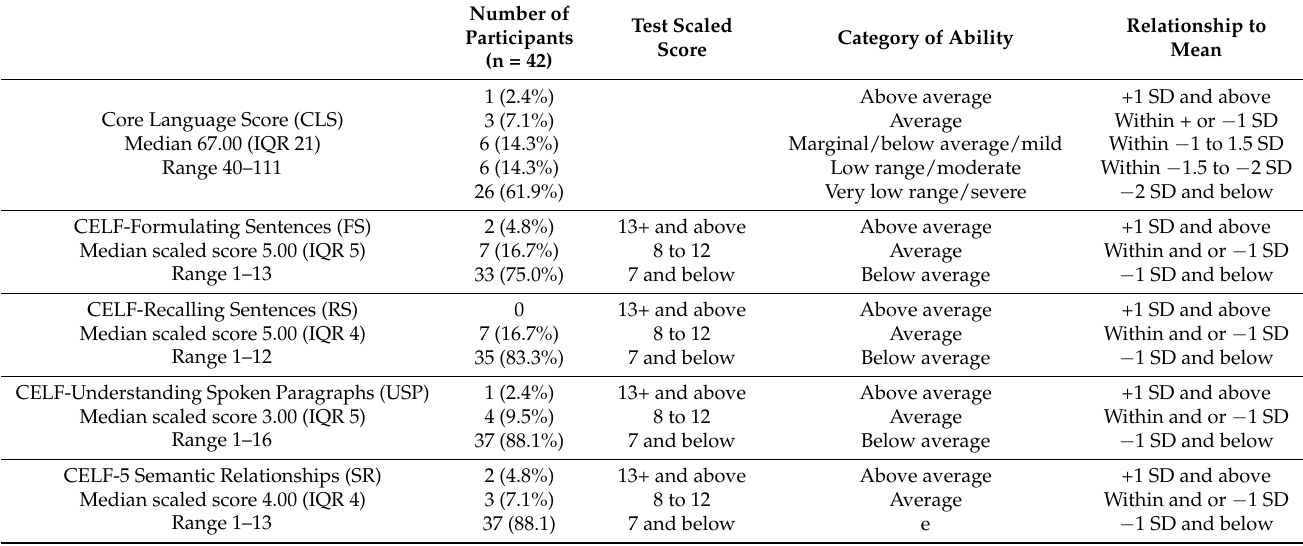
Table 1. CELF-5 UK Core language median and mean subscale scores, standard deviations, ranges, and categories of ability.